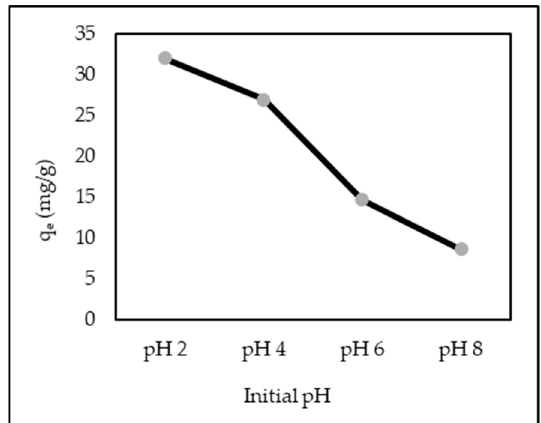
Figure 3. Effect of different initial pH of AR88 solution (ZL–CH hydrogel 30 mg, 100 mL of 10 mg/L AR88, contact time 15